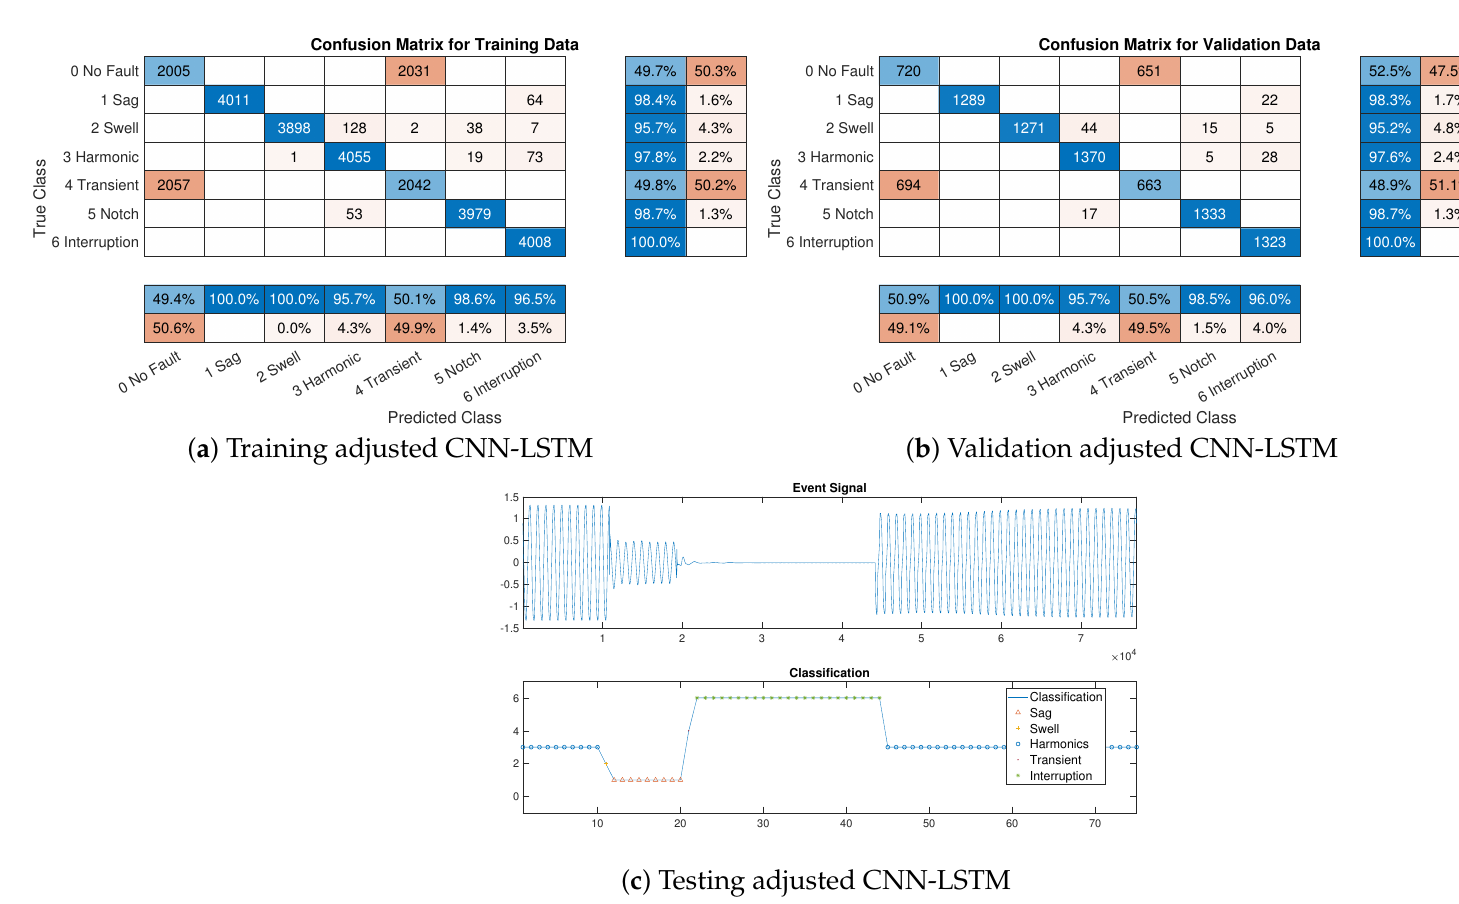
Figure 12. ( a ) Confusion matrix of the CNN-LSTM with adjusted hyperparameters training, ( b ) Confusion matrix of the CNN-LSTM with adjusted hyperparameters validation, ( c ) Testing of the CNN-LSTM with adjusted hyperparameters using a simulated voltage waveform.